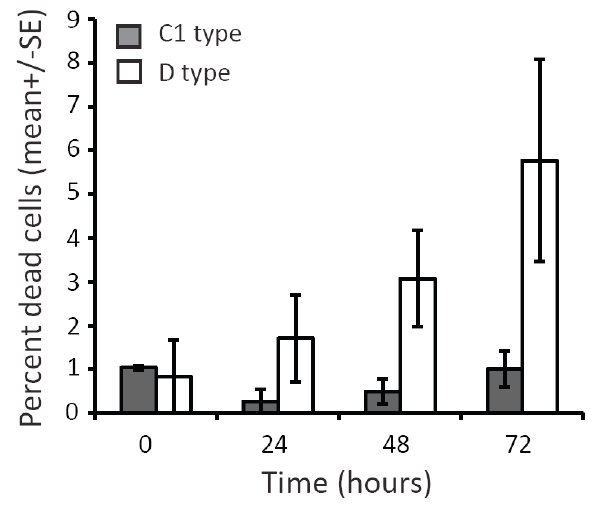
Figure 1. Comparison of mean percentage of dead cells between C1 and D Symbiodinium at four times after extraction. Grey bars = type C1 (mean ± SEM); white bars = type D (mean ±